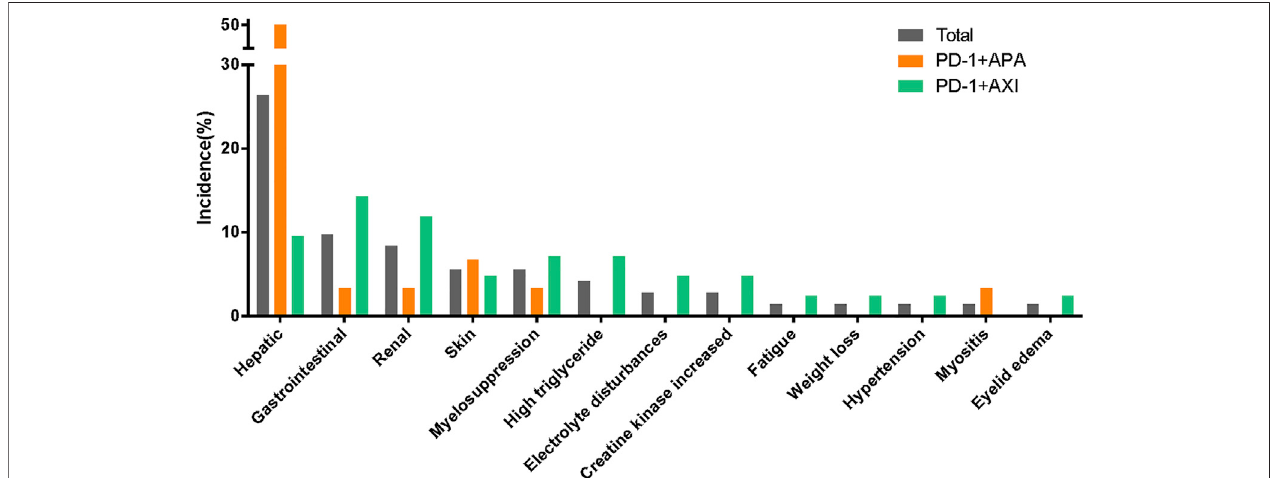
FIGURE 2 | Treatment-related adverse events leading to discontinuation between different therapeutic regimens.